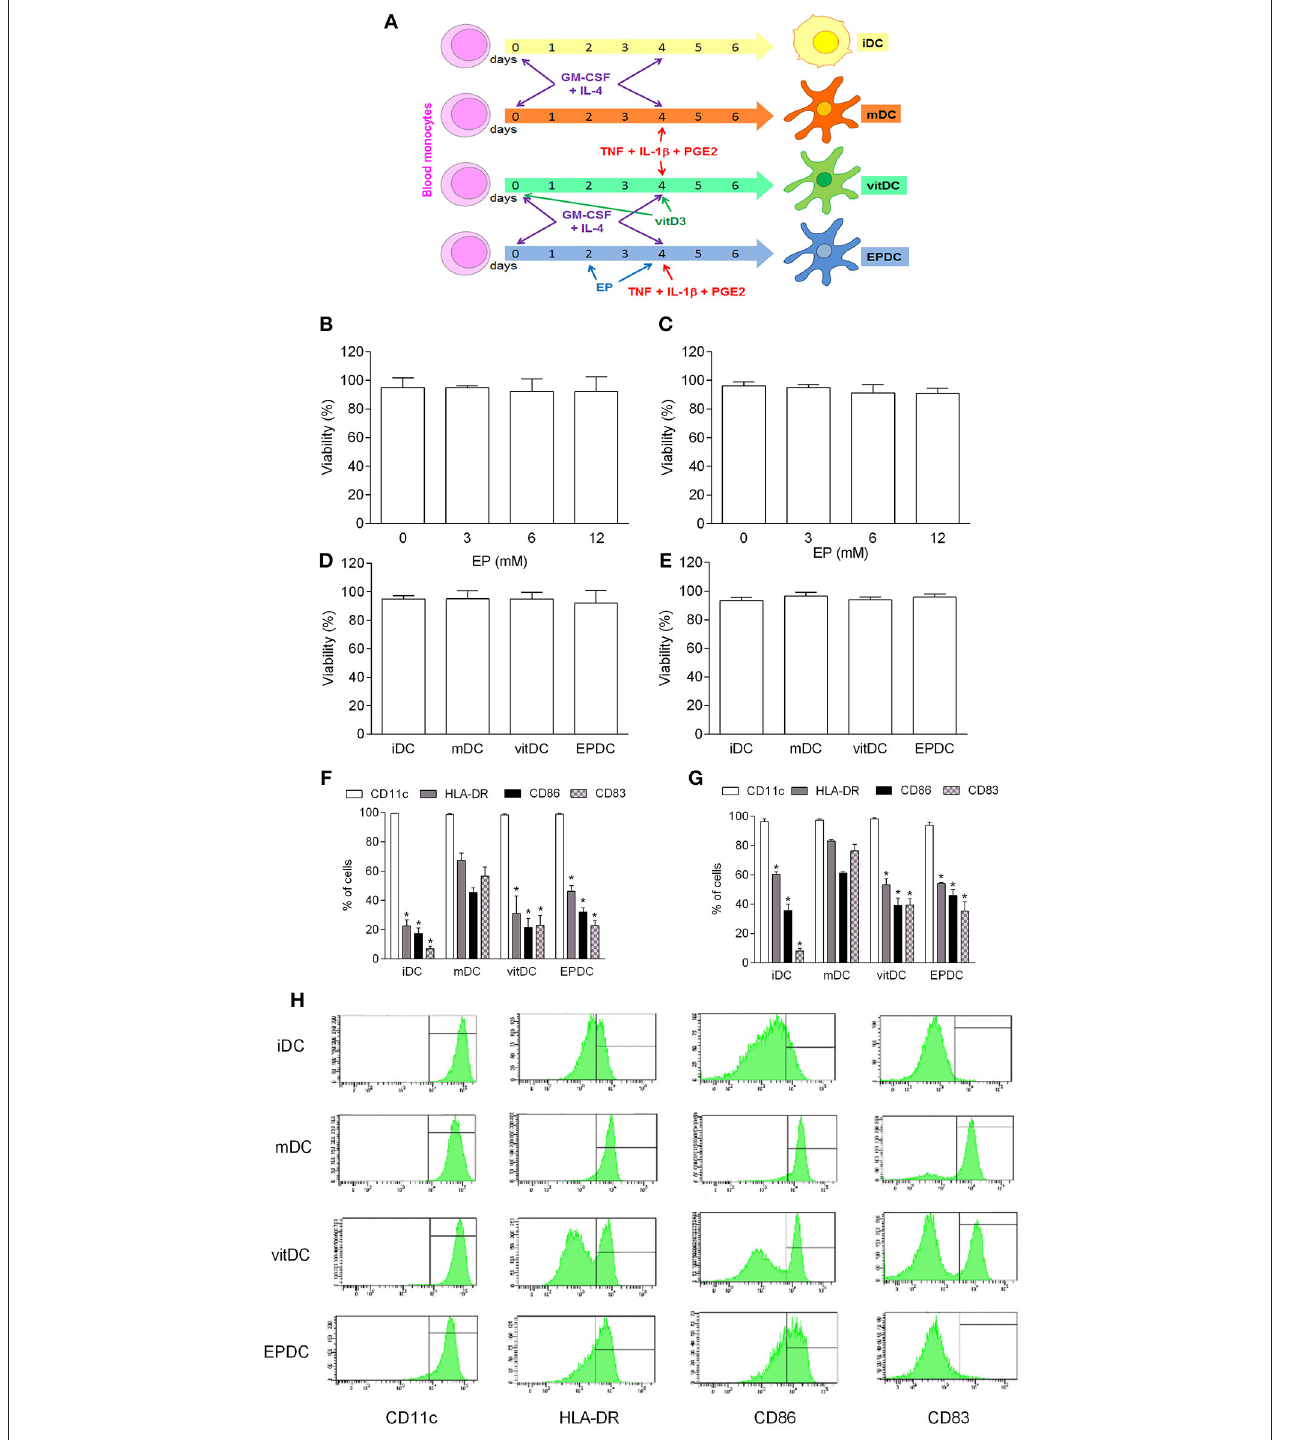
FIGURE 4 | Effects of EP on human DC. MDDC were propagated from peripheral blood monocytes and matured in the presence of TNF + IL-1 β + PGE 2 (mDC, vitDC, tEPDC) or were left immature without the treatment (iDC) as depicted (A) . MDDC were obtained from healthy subjects (B,D,F,H) or from individuals affected by multiple sclerosis (C,E,G) . EP was applied in various concentrations (B,C) or in concentration of 6.2mM ( D–H , EPDC). Vitamin D3 (vitDC) was applied in concentration of 1nM. Viability (B–E) was determined by 7AAD test. Proportion of cells expressing the listed antigens was determined by cytofluorimetry (F–H) . Data are presented as mean + SD from at least five individuals. Data in H are representative plots. * p < 0.05 vs. mDC, two-tailed t -test.